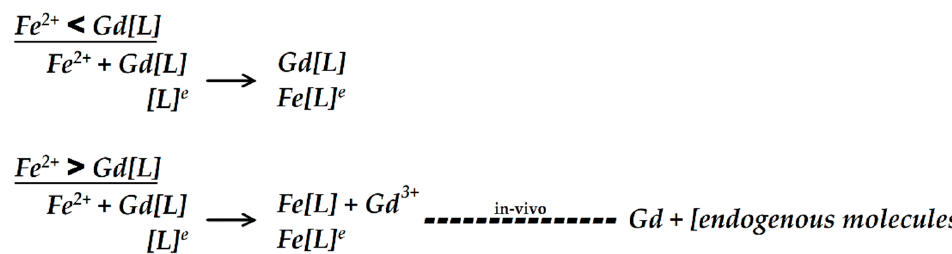
Figure 4. Proposed mechanism of how the concentration ratio between Fe 2+ and chelated gadolinium (Gd[L]) contributes to transmetalation. When the Fe 2+ concentration is lower than Gd[L] with excess ligand [L]e, Fe 2+ will bind primarily with the [L]e before competing with Gd[L]. However, when the Fe 2+ concentration is higher than Gd[L], the [L]e may not be sufficient for Fe 2+ binding. Consequently, Fe 2+ will compete with Gd[L], resulting in Gd 3+ being released from its chelate (transmetalation). When transmetalation occurs in vivo, Gd 3+ may bind with endogenous molecules such as phosphate or carbonate or may form a macromolecule complex. Table 1. Characteristics of Magnevist ® and Gadovist ® [2,32,33]. Gadopentetate Dimeglumine